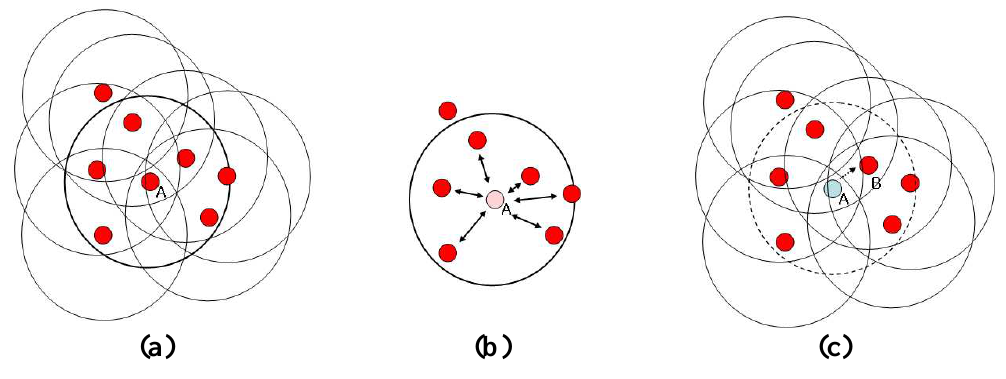
Figure 5. Example of using optimization algorithm as clustering algorithm